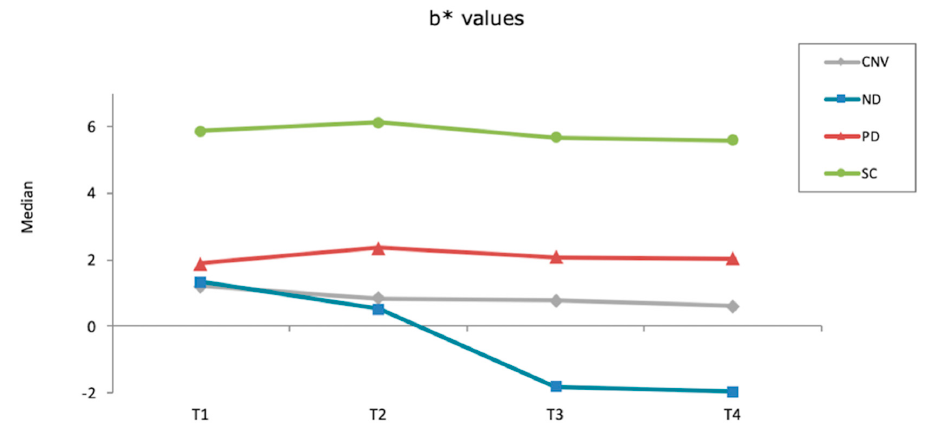
Figure 3. b* values of each material after each procedure (T1: After polish; T2: After first brushing cycle; T3: After thermocycling; T4: After second brushing cycle).